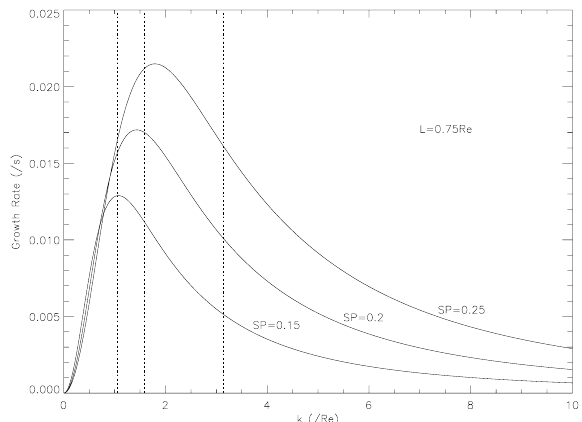
Fig. 2. Background magnetic field magnitude in the domain ( L = 0 . 75 R E ). Each labeled line indicates an unstable domain. Ends of each line indicate the boundaries of the domain.